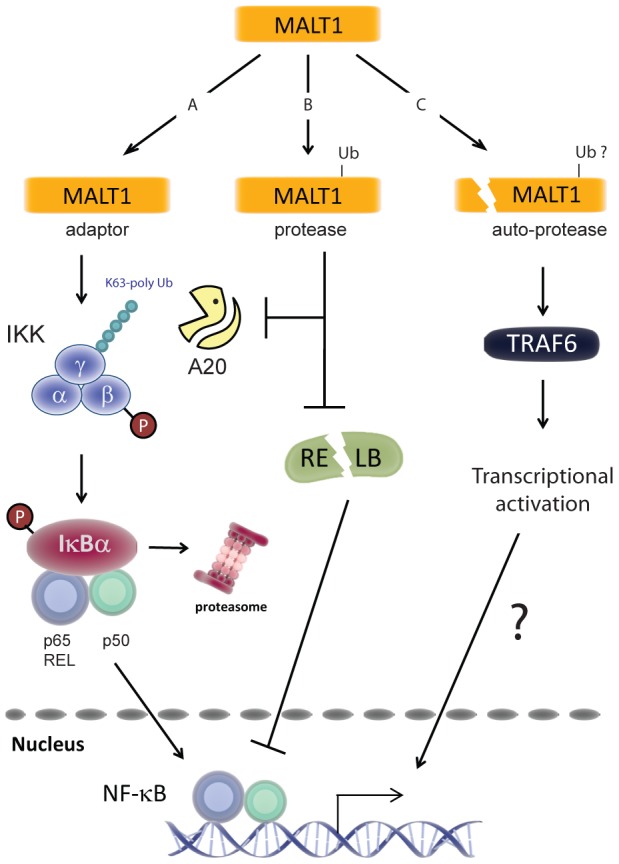
Model for MALT1 functions in TCR-mediated NF-κB1 activation.A) The adaptor function of MALT1 is required for TCR-mediated activation of the IKK complex. Via formation of the CARMA1/BCL10/MALT1 complex MALT1 controls TRAF6-mediated K63 poly-ubiquitination of the gamma subunit of the IKK complex. Concurrent phosphorylation of IKKβ activates the IKK complex that phosphorylates the NF-κB inhibitor IκB, induces its proteasomal degradation and allows nuclear translocation of NF-κB complexes consisting of p50, p65 and REL. B) Parallel induction of MALT1 protease activity prevents de-ubiquitination of IKKγ and possibly other substrates via A20 cleavage and facilitates DNA binding of p65- or REL-containing NF-κB complexes via RELB cleavage. C) MALT1 auto-proteolysis represents a third level of MALT1 regulation that controls in a TRAF6-dependent and BCL10-independent manner the transcriptional activation of nuclear NF-κB complexes via a yet unknown mechanism.